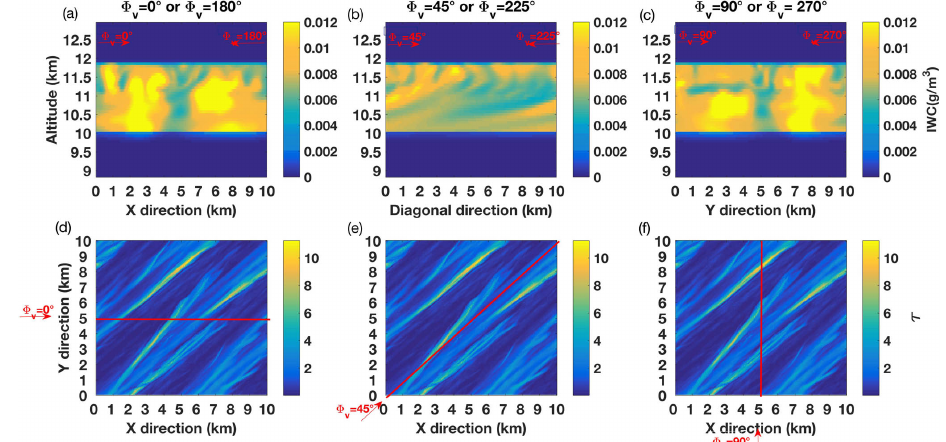
Figure 1. Top panels ( a , b , c ): vertical distribution of the ice water content (IWC ( gm 3 ) ) following the red lines through the 50m spatial resolution optical thickness field shown in the bottoms panels ( d , e , f ) along the red line as a function of the azimuth viewing angle (cid:56) v